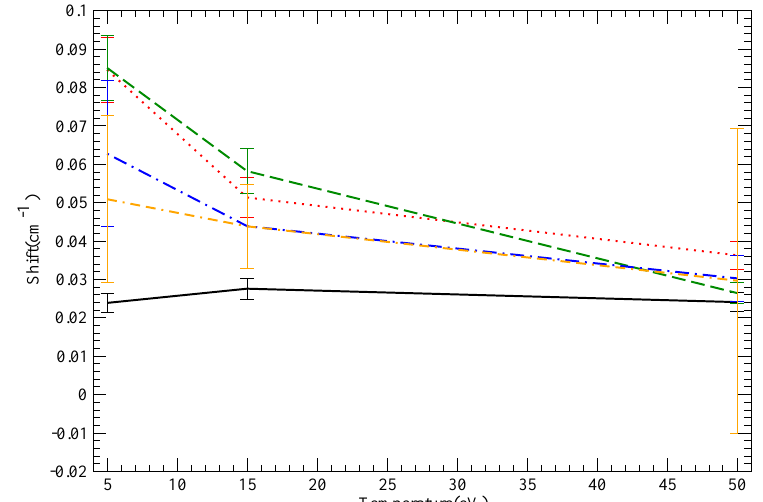
Figure 7. A comparison of B III 2s-2p transition shifts as computed by SCP (solid black), SimU (dotted red), DARC (dashed green) and Starcode with (dash-dotted blue) and without (dot-double dash orange) penetration accounted for.